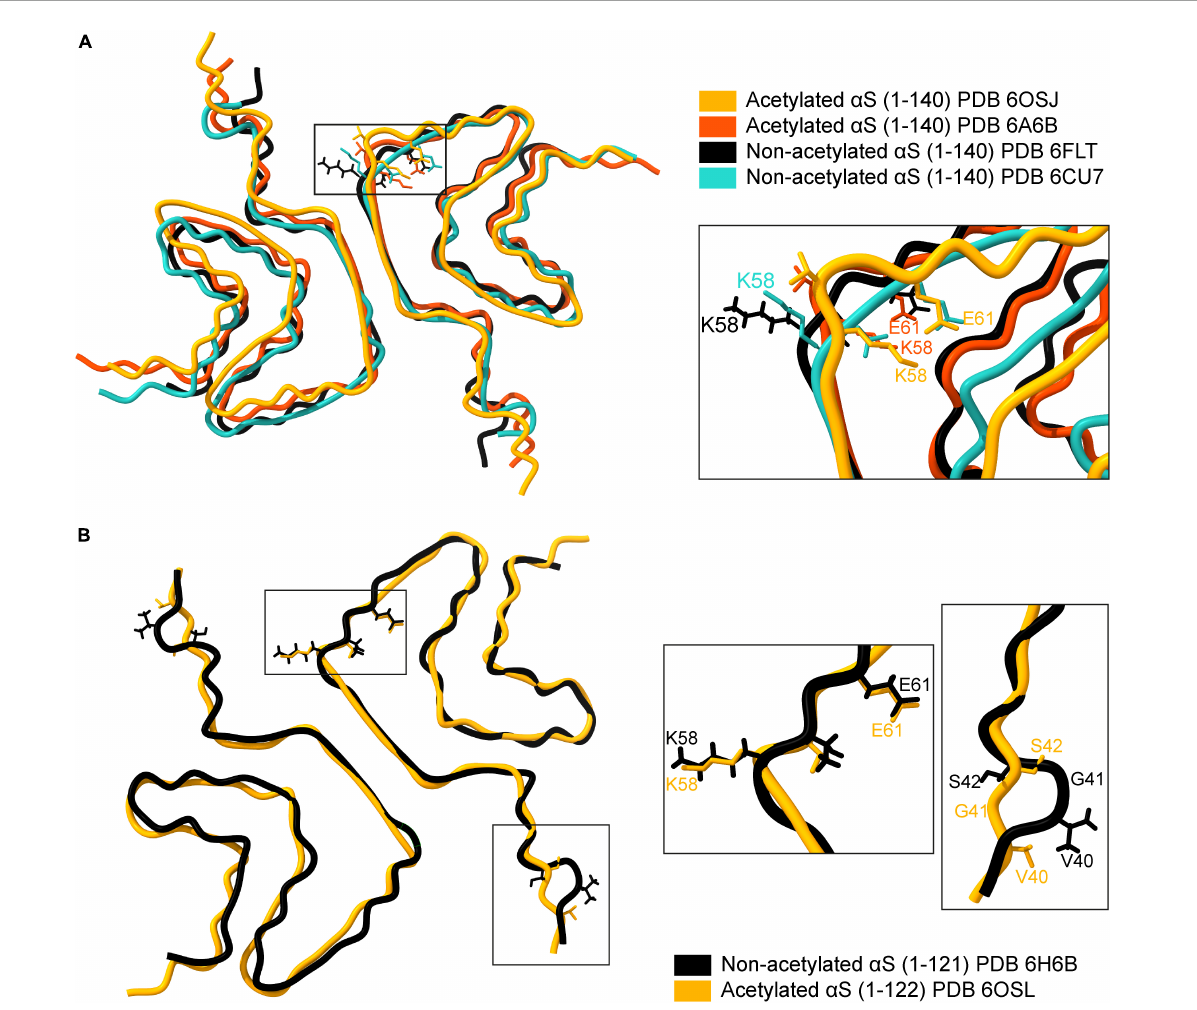
FIGURE4 Comparison of available cryo-EM structures of the full-length acetylated (yellow, PDB ID: 6OSJ and orange, PDB ID:6A6B) and non-acetylated α S fibrils (black, PDB ID: 6FLT and blue, PDB ID:6CU7). (A) The backbone overlay of acetylated and non-acetylated α S fibrils is shown. The residue K58 in both acetylated α S fibrils is flipped inward, forming a salt bridge between K58-E61 (see inset). In contrast, the salt bridge is broken in acetylated α S fibrils due to the outward flip of K58. (B) The backbone overlay generated using ChimeraX of truncated (1-121/2) acetylated (yellow, PDB ID: 6OSL) and non-acetylated α S fibrils (black, PDB ID: 6H6B) depicting flipped K58 residues irrespective of acetylation state and minor loop fluctuations around the G41